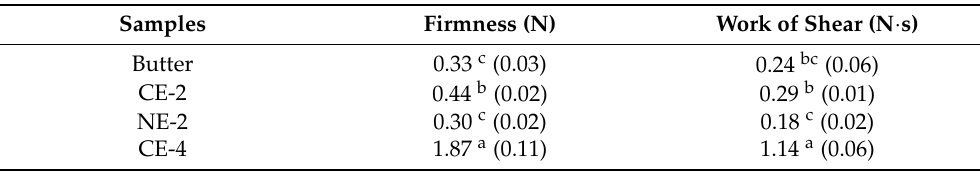
Table 3. Firmness and work of shear of butter, conventional emulsions (CE) and nanoemulsion (NE) stabilised with HPMC (0%, 2% and